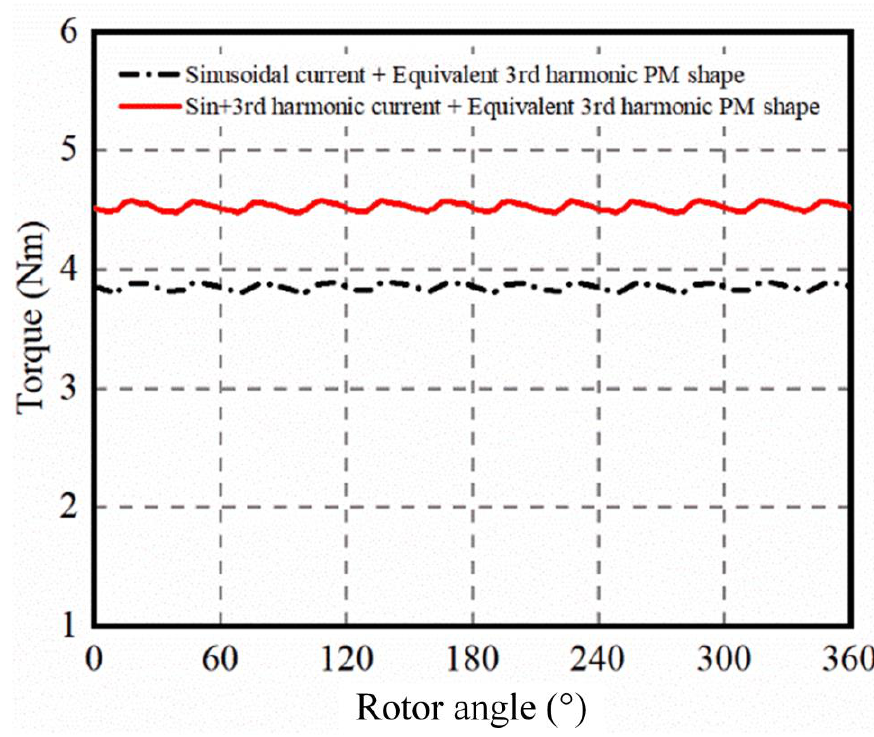
Table 8. Performance comparison of dual three-phase PMSM with the same current type.